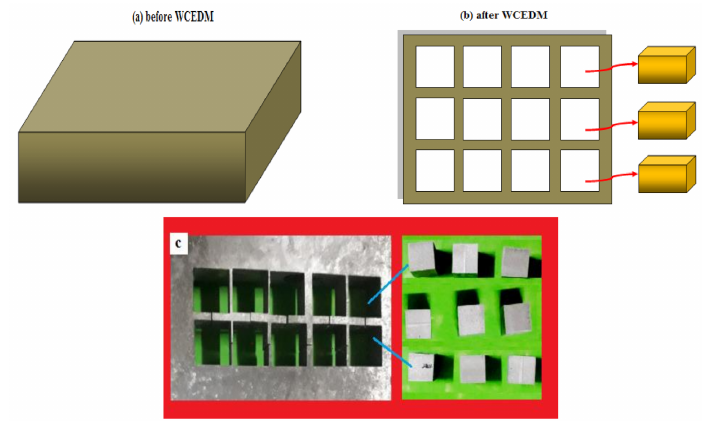
Figure 1. Schematic view of ( a ) casted AZ61Mg specimen ( b ) after WCEDM (Wire Cut Electrical Discharge Machining) specimen and ( c ) casted raw material with machined